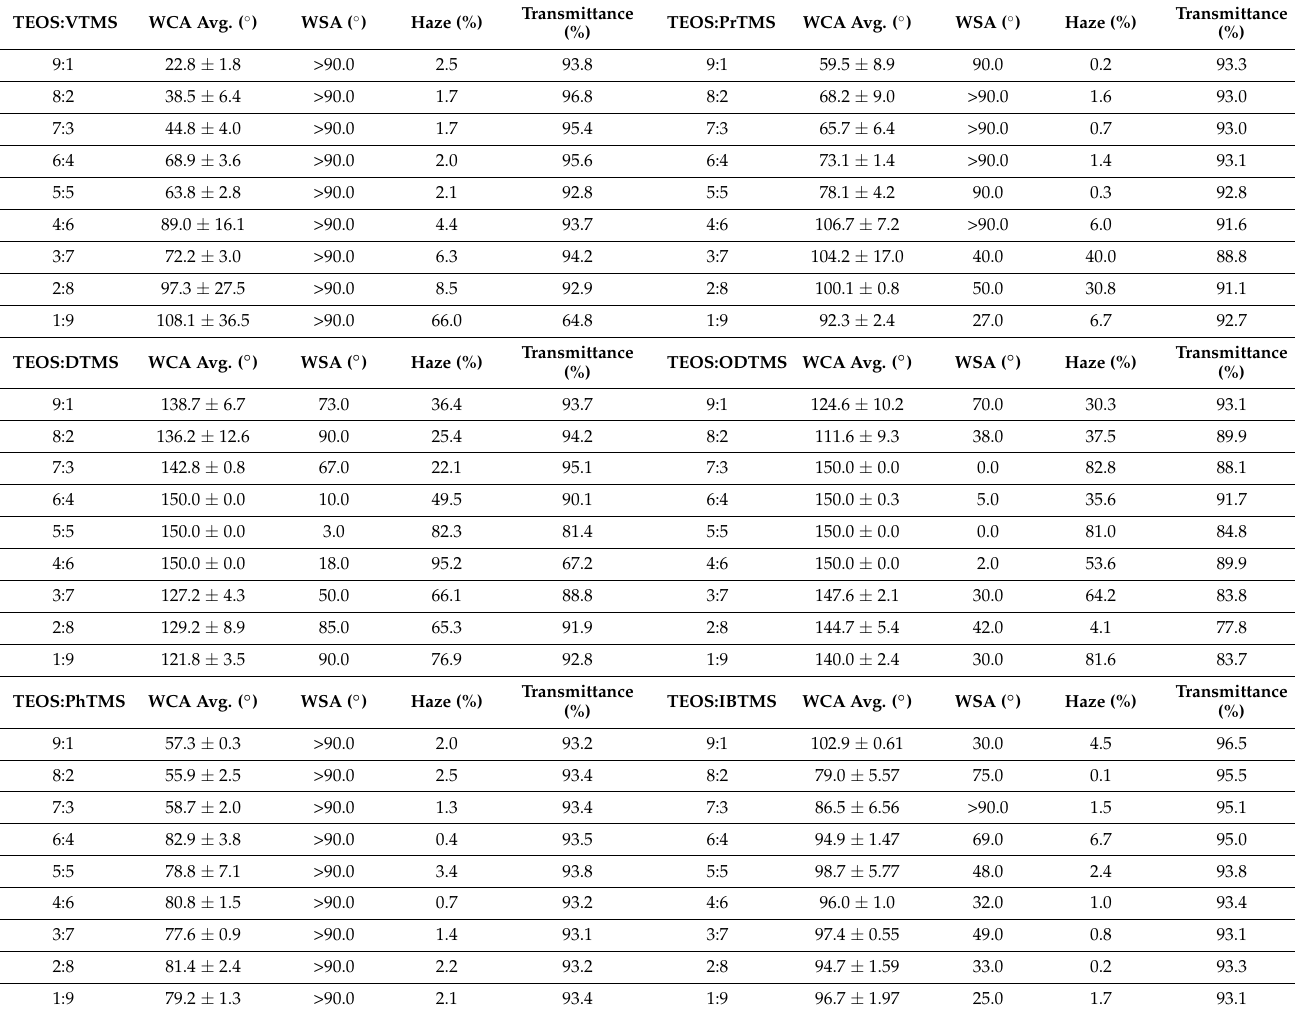
Table 1. Wettability and optical properties of coatings using various precursors concentration of 0.09 M. VTMS: vinyl trimethoxysilane. ODTMS: octadecyl trimethoxysilane; WCA: water contact angle; WSA: water sliding angle; VTMS: